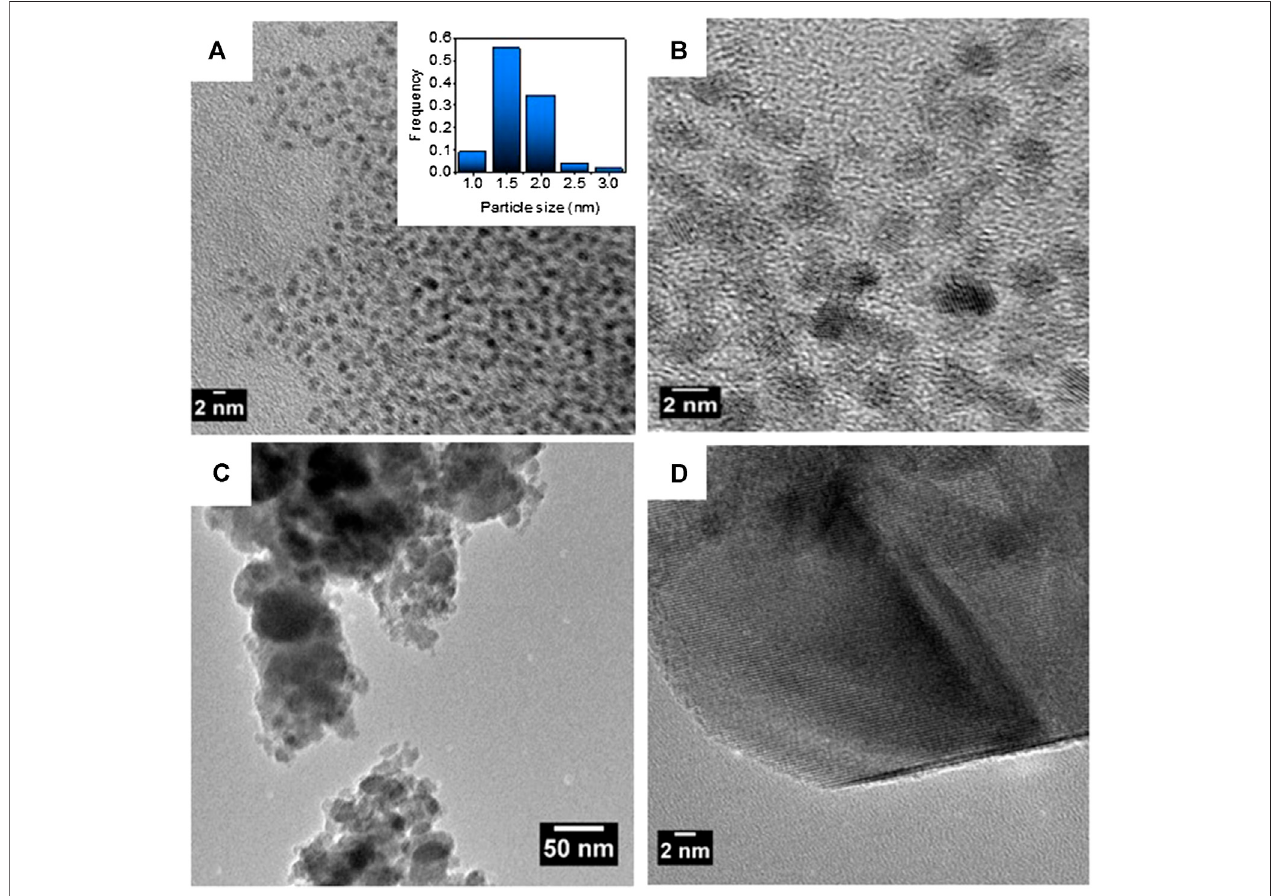
FIGURE3|(A) TEM image ofH-RuO 2 (inset: related histogramofparticlesizedistribution) and (B) HRTEM image ofH-RuO 2 (C,D) TEM image and HRTEM image of